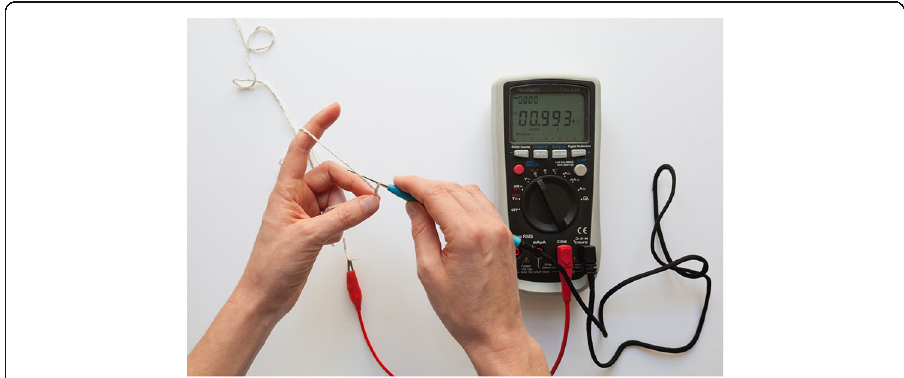
Fig. 4 Crochet hook connected to a multimeter to give direct feedback about the resistance value of the crochet in the